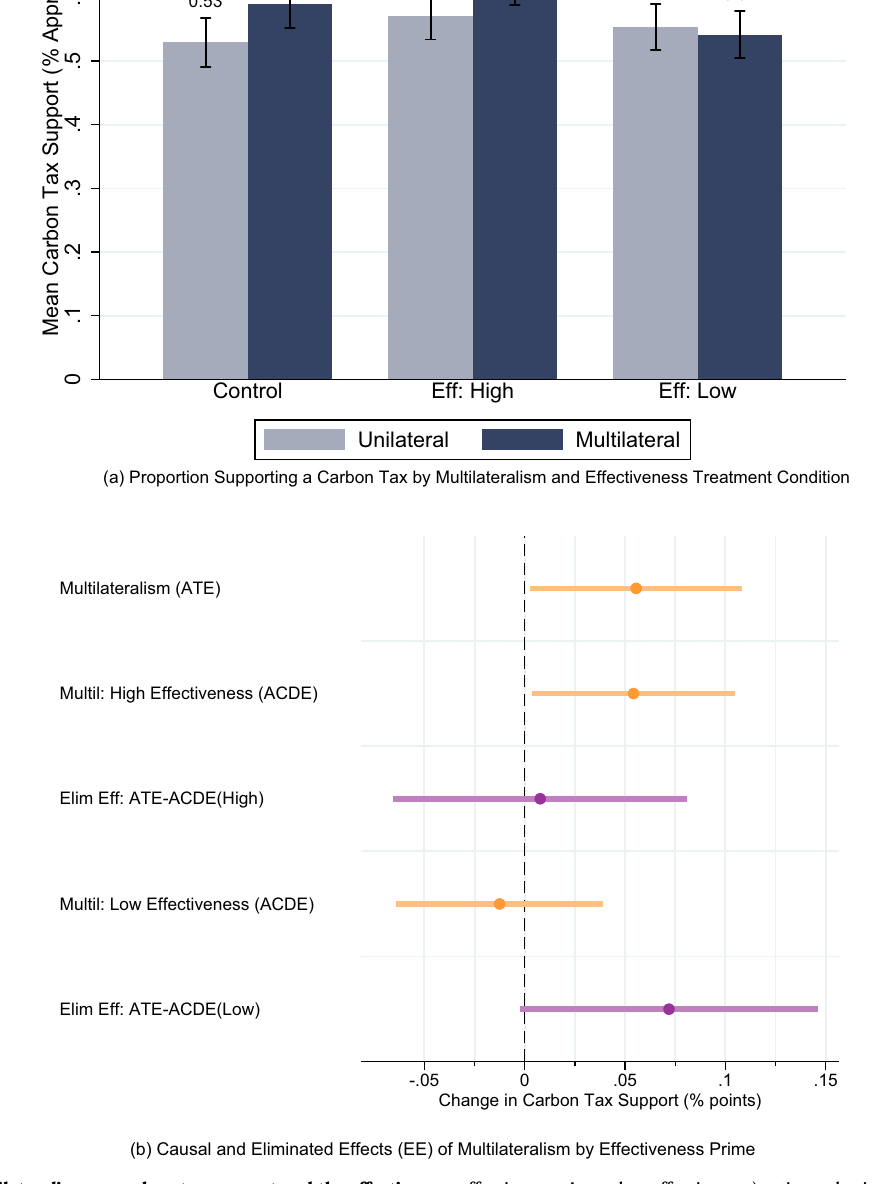
effectiveness, Low=low effectiveness) estimated using a linear probability model with robust standard errors. Regressions control for gender, age, income, educa- tion, and employment status. Country fi xed effects included. Error bars indicate 95% con fi dence intervals. N (France)=2000, N (Germany)=2000, N (United Kingdom)=2000. Unweighted results are very similar, see Supplementary Fig.